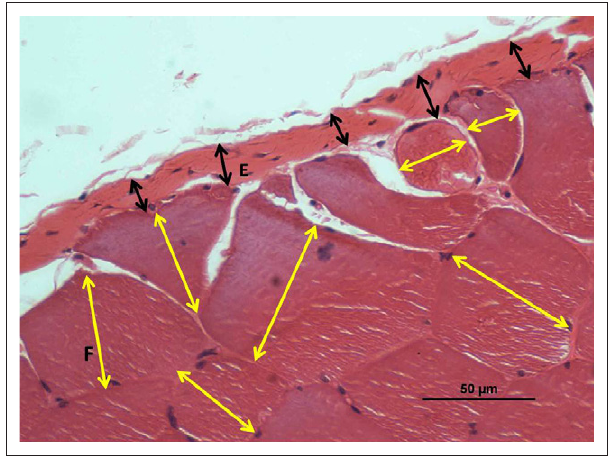
FIGURE 1: Haematoxylin-stained section showing distribution of cross-sectioned myofibres and epimysium in untraumatised rabbit skeletal